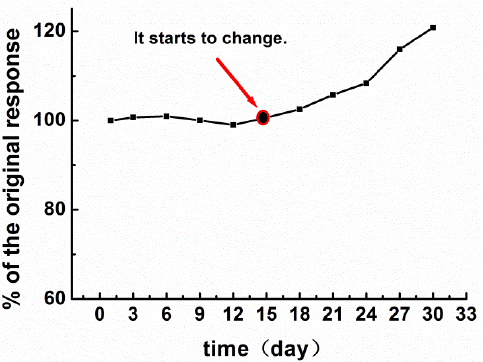
Figure 6. Stability of the response of the FIA biosensor with respect to a COD of 100 mg/L, as determined over 30